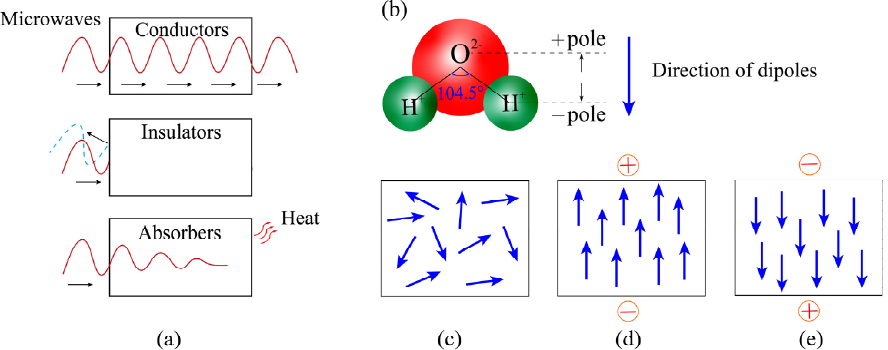
Figure 22. ( a ) Interaction of microwave with different materials; ( b ) the structure of water molecule; ( c ) direction of dipoles under natural state; ( d , e ) dipoles rotate influenced by electric field.